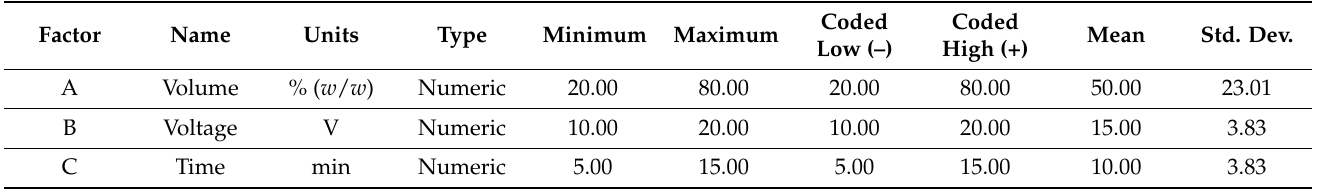
Table 2. Input factors used in the experiment for 20 and 80% water volume ratio.